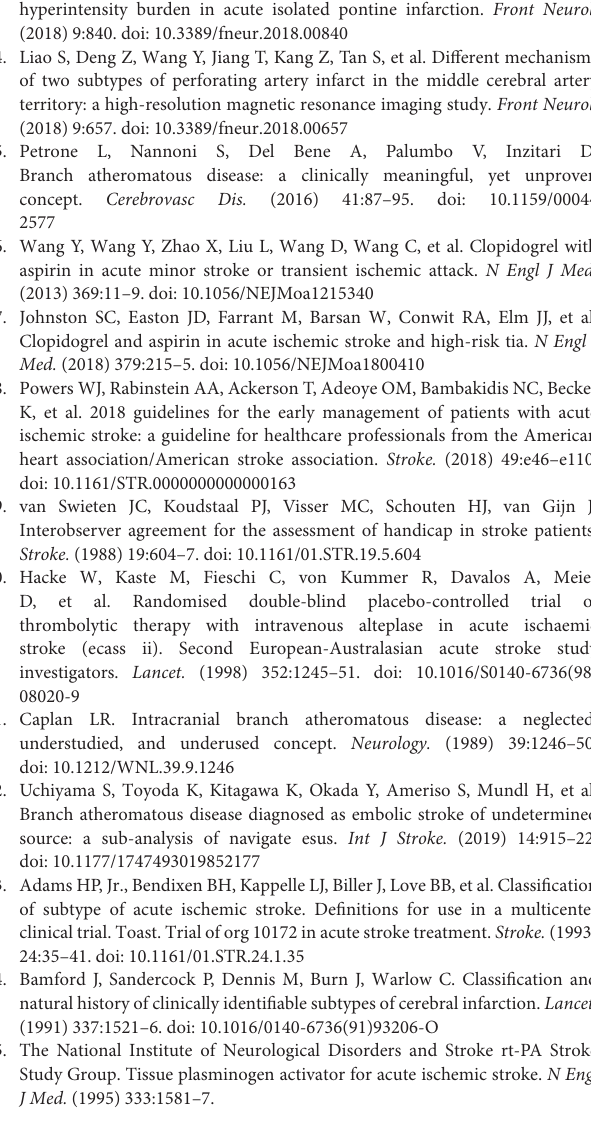
Supplementary Table 1 | Baseline characteristics and outcomes were compared between included and excluded groups. Supplementary Table 2 | Baseline characteristics and outcomes were compared between END and non-END